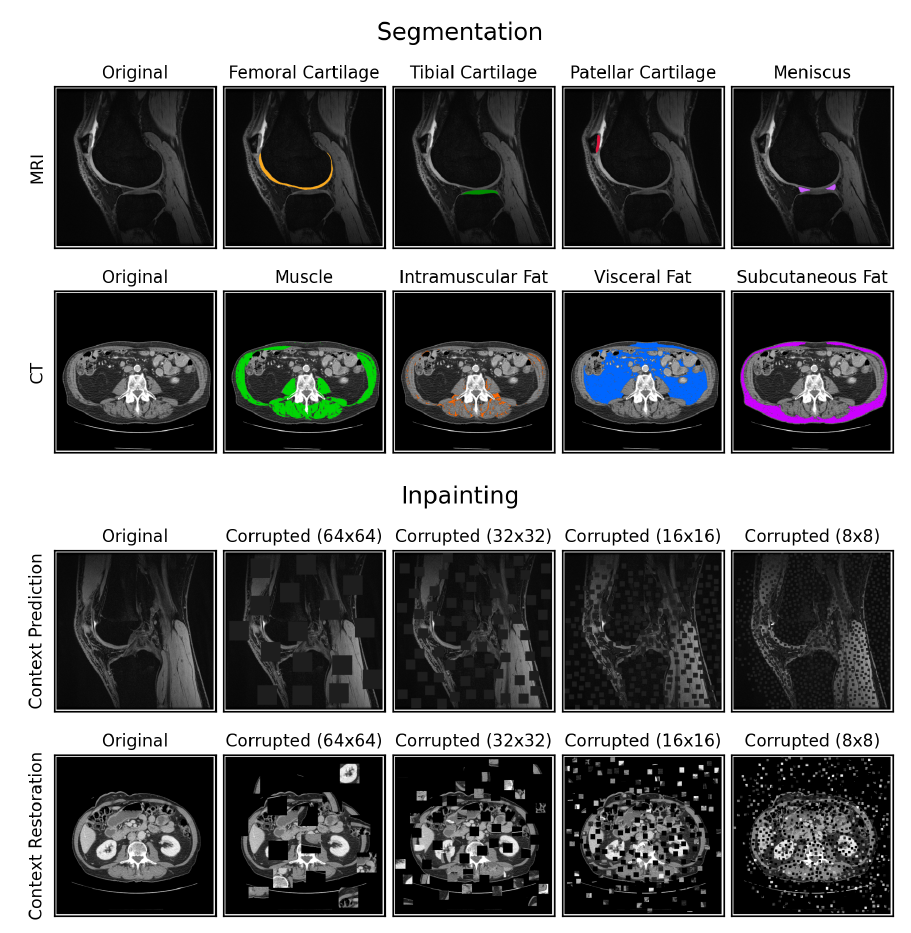
Figure 1. Example ground truth segmentations for the MRI and CT datasets (both with dimensions 512 × 512), and example image corruptions for context prediction (zero-ing image patches) and context restoration (swapping image patches). Since image corruption happens after normalization, the zero-ed out image patches for context prediction were actually replaced with the mean of the image. The “Inpainting” section depicts image corruptions with four different patch sizes: 64 × 64, 32 × 32, 16 × 16, and 8 × 8. The locations of these patches were determined using Poisson-disc sampling to prevent randomly overlapping